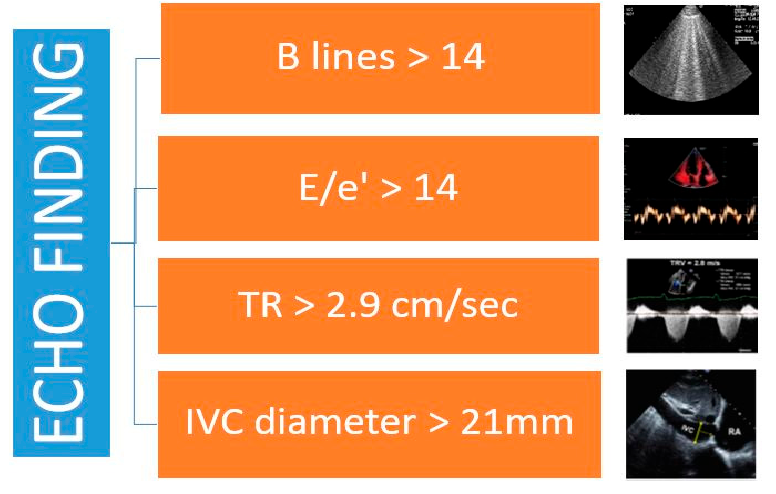
Figure 2. Echographic findings in HF.